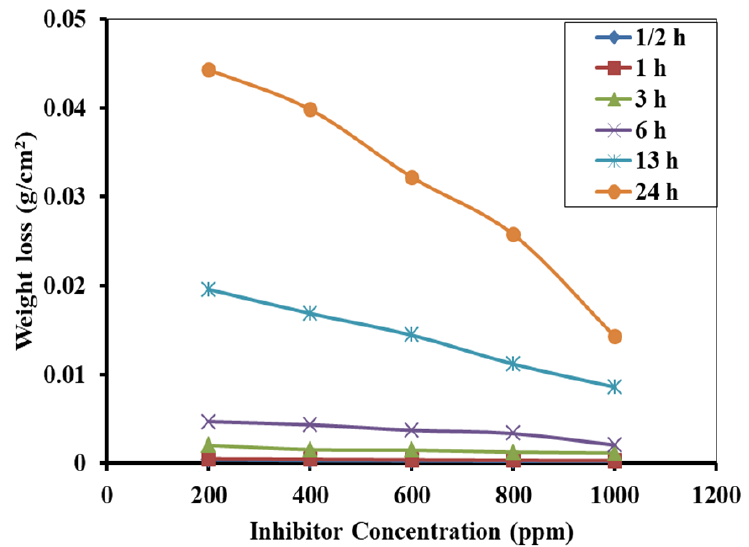
Figure 3. Variation of weight loss with different concentrations of ST alkaloid on MS in 1M H 2 SO 4 solution at 20 ° C at different intervals of immersion time.